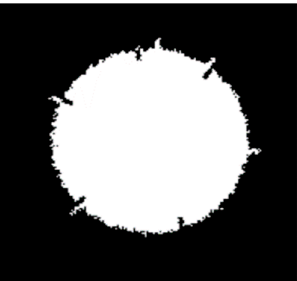
Figure 8. Slice of a sphere with cavities and outliers on a surface.